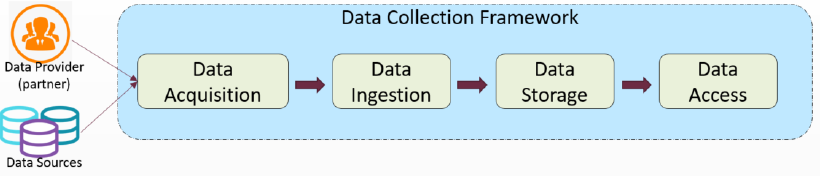
Figure 3. Data collection system.